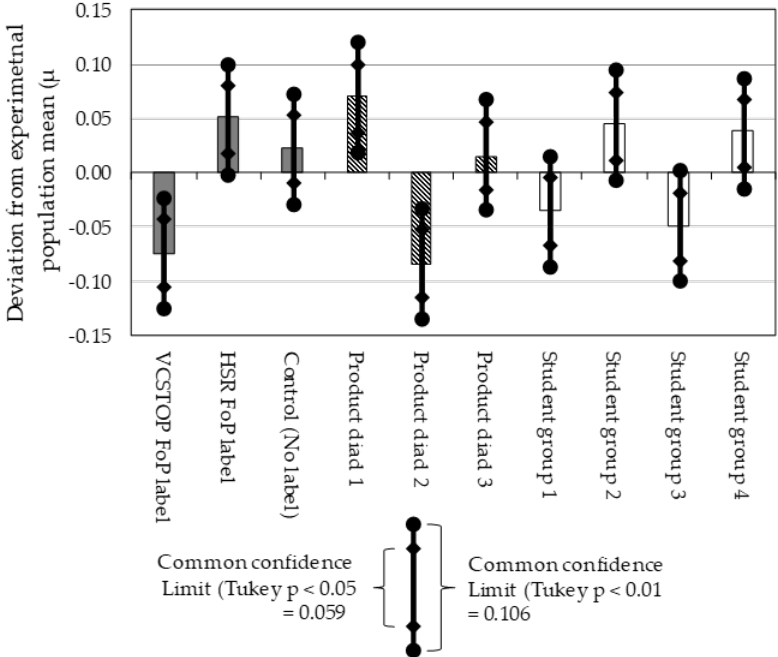
Figure 8. Deviation of FoP treatments (shaded bars), choice diads (hatched bars) and student groups (white bars) from the experimental population mean ( μ = 0.50). The experimental population mean is the average of the responses from all cells within the experiment. Table 1. Adjusted analysis of variance table after Youden and Hunter [55].